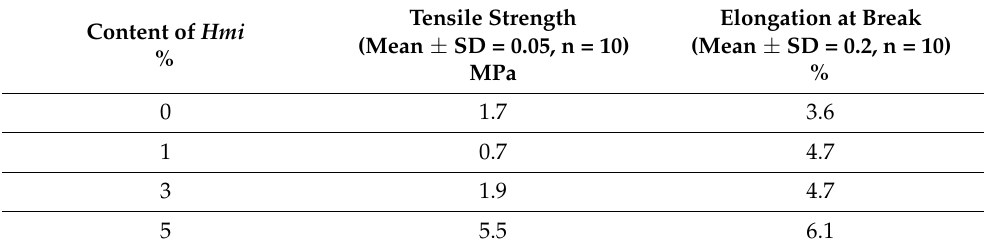
Table 2. Mechanical characteristics of the Hmi /PHB samples with different content of Hmi